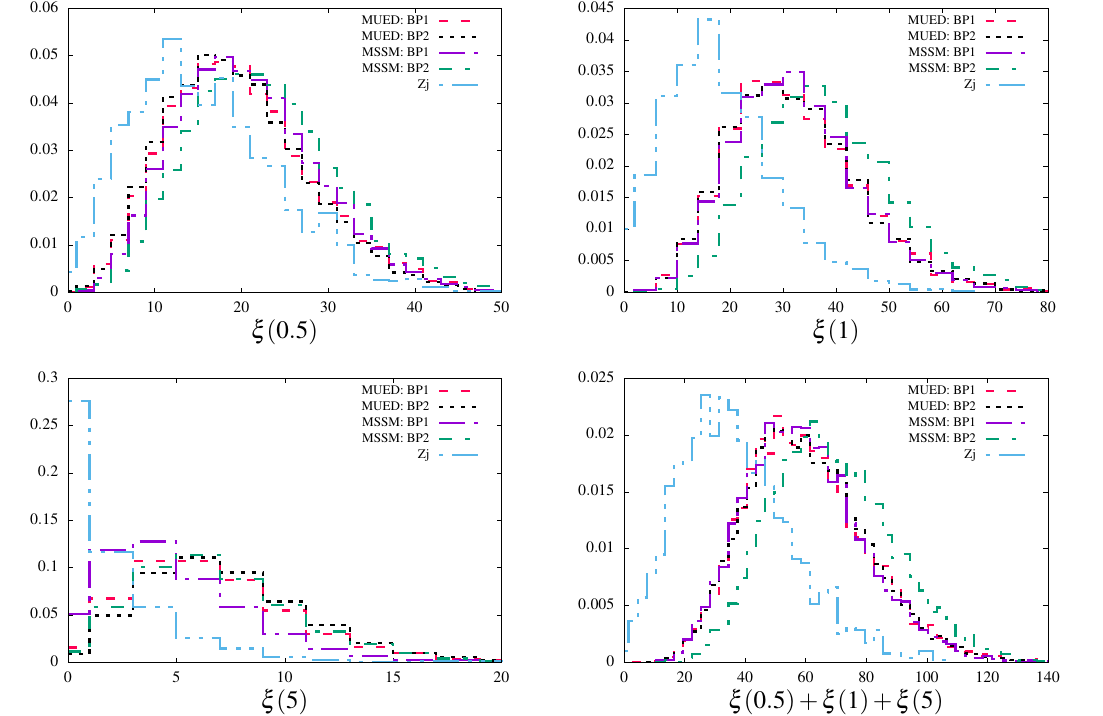
Figure 4 . Number of soft track distributions after eliminating the SM QCD background by applying the cut C2 : i.e., exclusive one jet with p j > 100 GeV, (cid:1) (cid:30) ( j; (cid:26) (cid:26) E T ) > 1 : 0 and (cid:26) (cid:26) E T > 400 GeV. A clear T distinction can now be observed between the signal benchmarks and the SM background of Z +jets.